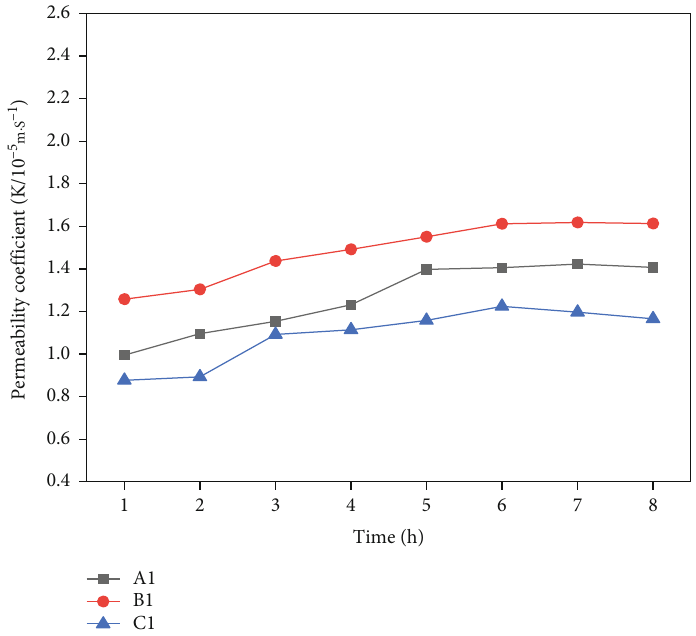
leaching sample. 4